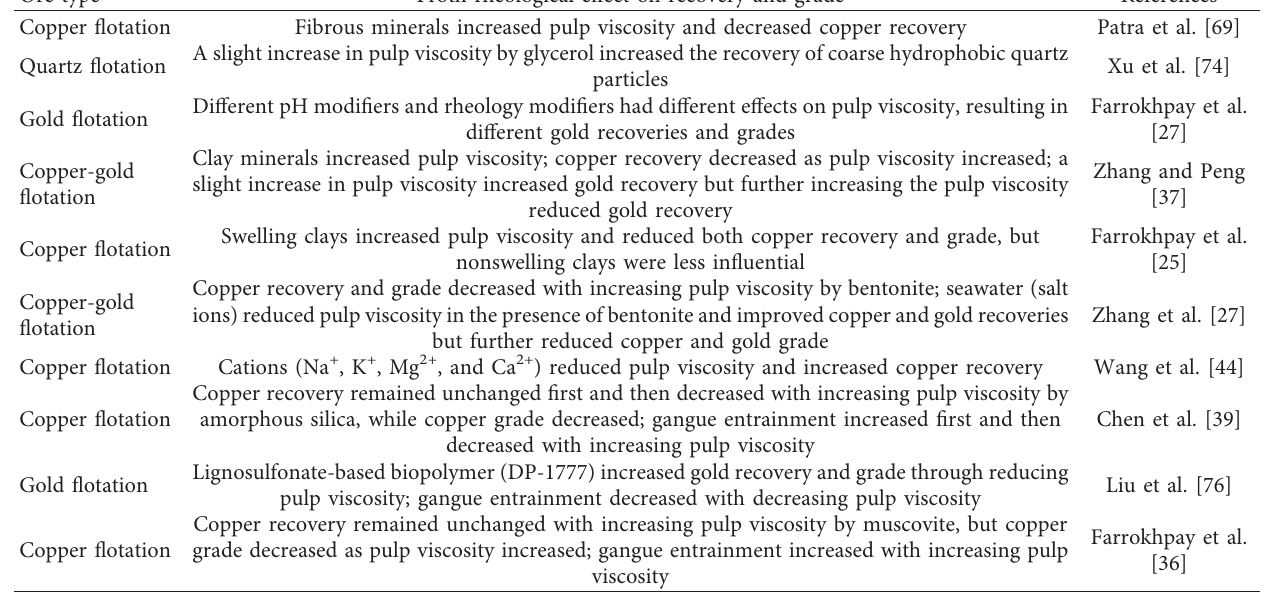
Table 1: Literature (part) related to pulp rheological effects on flotation recovery and grade.